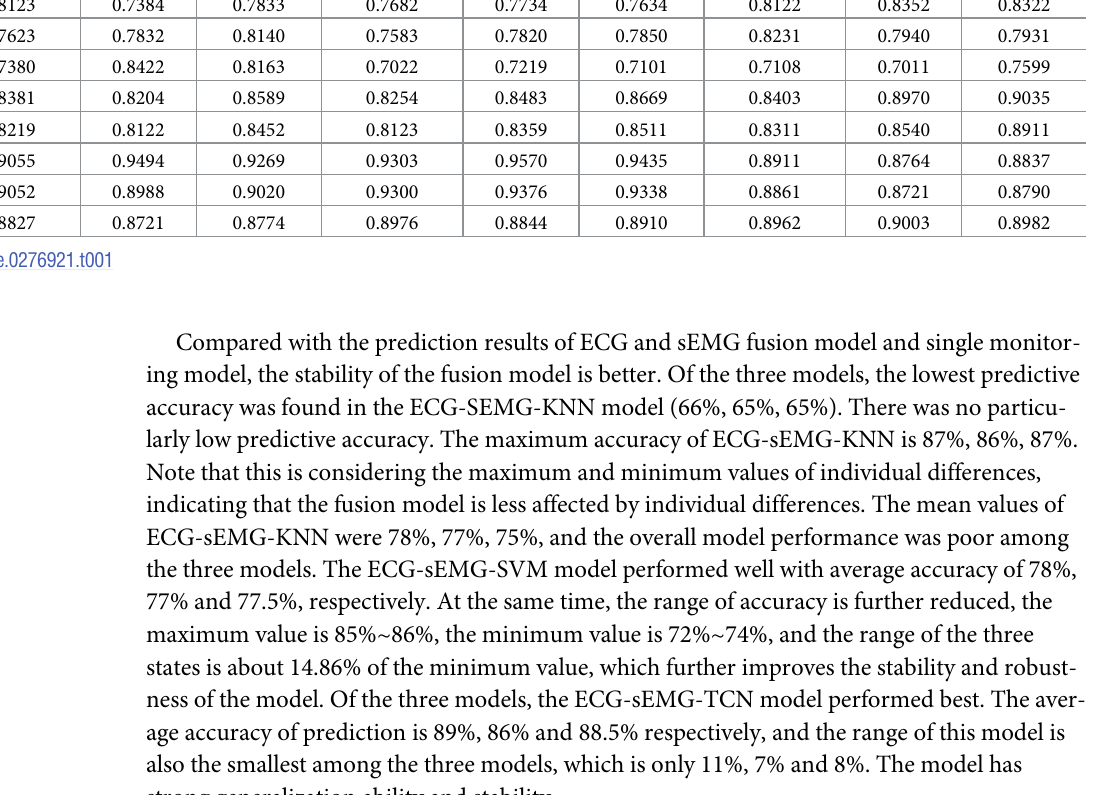
Table 1. The precision recall and F-score of three fatigue states.